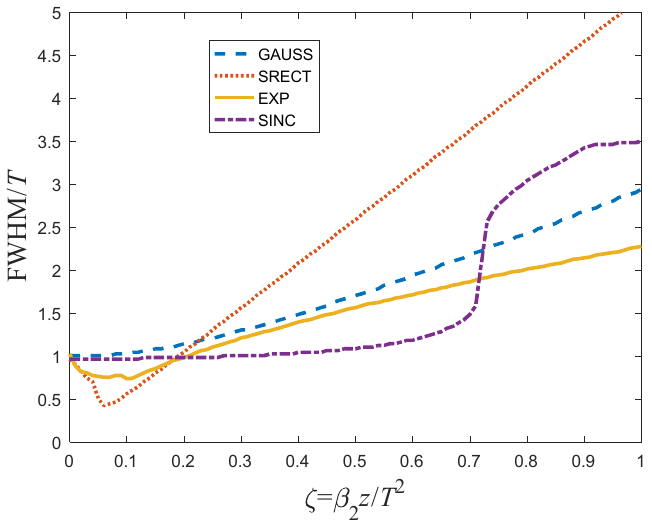
Figure 31. FWHM Comparison between four different pulses: Gaussian (dashed curve), Rectangular (dotted curve), Exponential (solid curve), and Sinc (dot-dash).